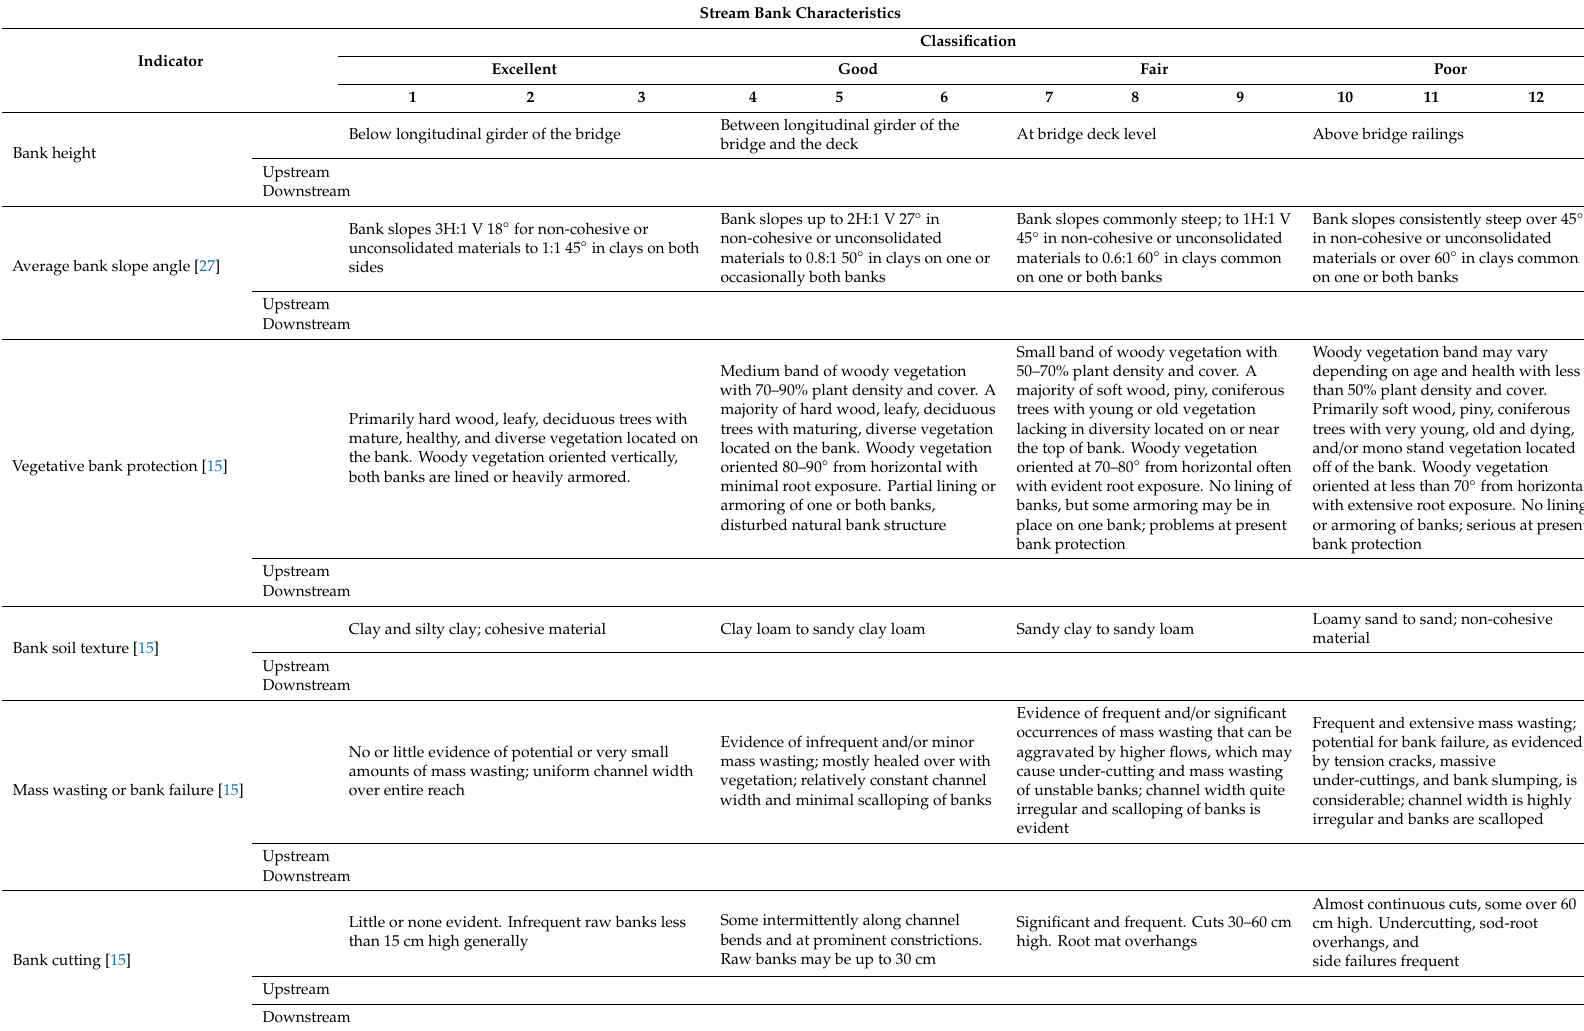
Table 5. Stream bank